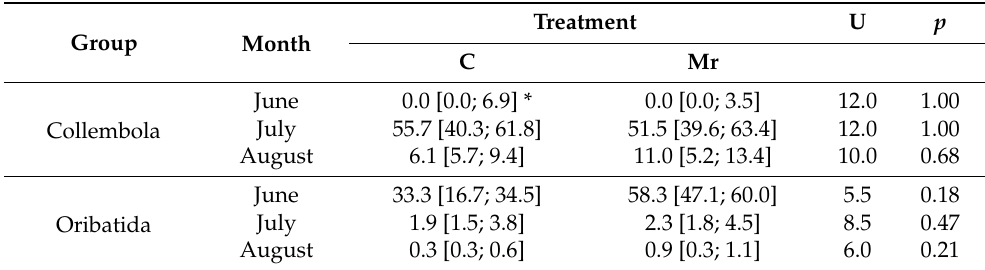
Table 6. Results of comparative analysis of the proportion of individual groups in the community in the plots with different types of seed treatment in 2020 (Mann–Whitney